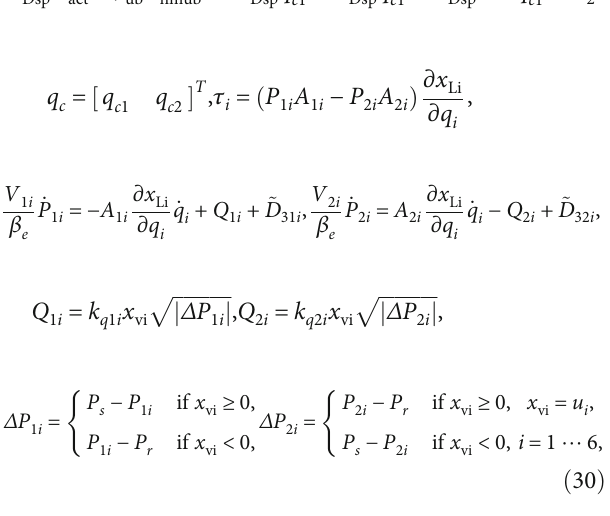
Figure 4: Human-machine interaction force minimized in left leg support. In this walking phase, six interaction force components at the back and right foot contact points will be